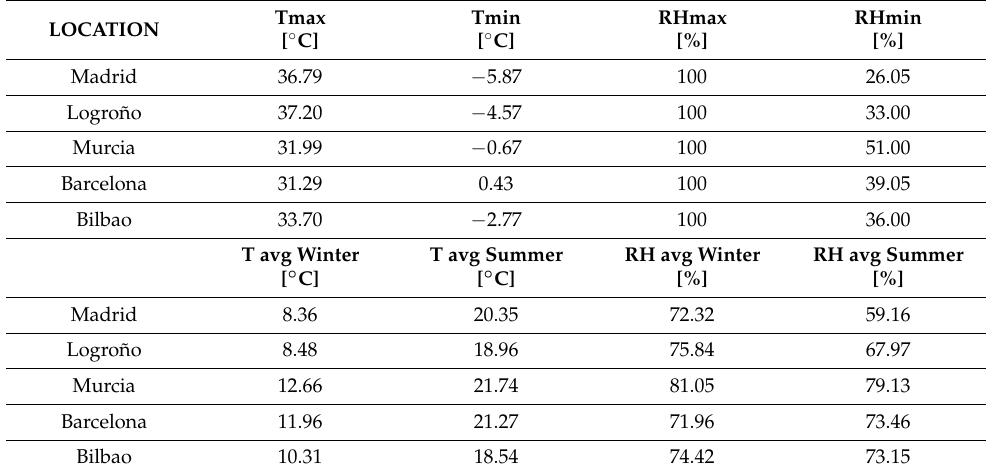
Table 1. Climatic extreme conditions and average conditions of 5 cities in Spain.